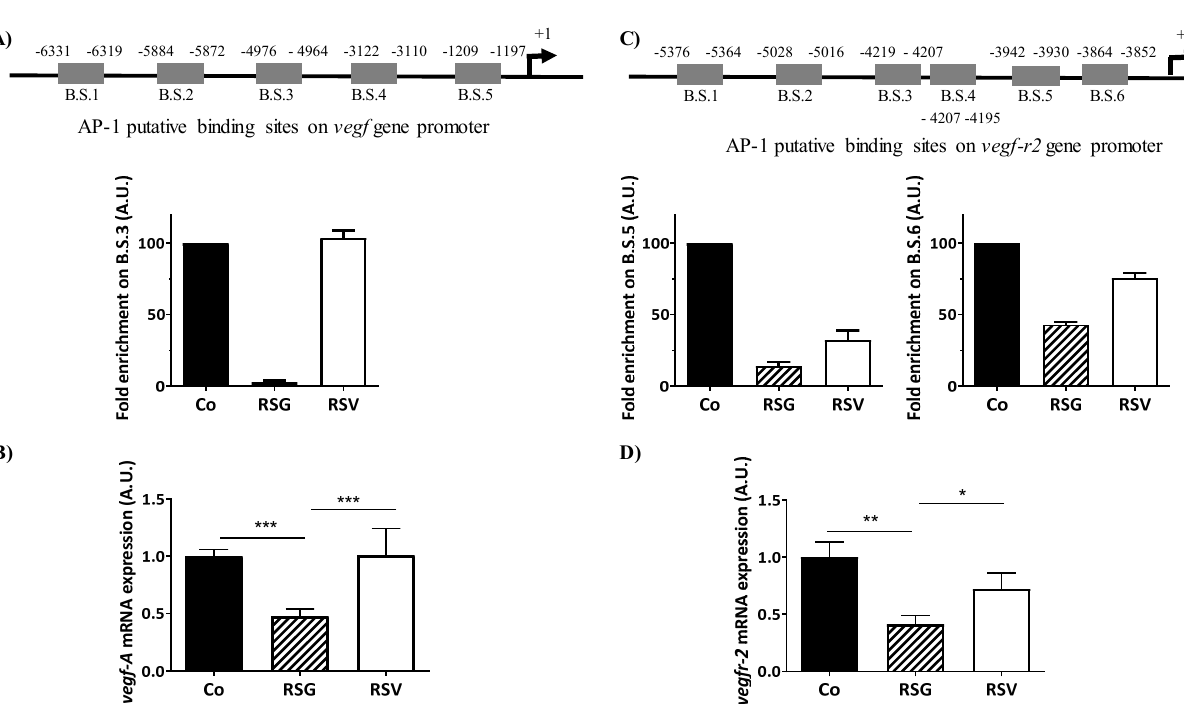
Figure 6. RSG inhibits vegf-a and vegf-r2 mRNA expressions through a disruption of the AP-1 binding sites. ARPE-19 cells were untreated (Co) or treated with RSG (12 µM) or with RSV (20 µM) for 24 h. ( A ) Upper panel, analysis on the putative binding sites of AP-1 on the vegf-a gene promoter. Down panel, ChIP analysis of the interaction between AP-1 and the vegf promoter in ARPE-19 cells. Analysis of the putative B.S.3 for AP-1 on the vegf promoter ( − 4976 − 4964) is shown. For the putative B.S.1, B.S.2, B.S.4, and B.S.5, any amplification was obtained. ( B ) RT-qPCR mRNA expression analysis of vegf-a . Data represent three independent experiments. Data are expressed as the mean fold induction ± SEM of three independent experiments. p values were determined by a one-way ANOVA followed by Tukey’s multiple comparison test. * p < 0.05, ** p < 0.01 and *** p < 0.001. ( C ) Upper panel, analysis of the putative binding sites of AP-1 on the vegf-r2 gene promoter. Down panel, ChIP analysis of the interaction between AP-1 and the vegf-r2 promoter in ARPE-19 cells. Analysis of the putative B.S.5 and B.S.6 for AP-1 on the vegf-r2 promoter ( − 3942, − 3930, and − 3864, − 3852, respectively) is shown. For the putative B.S.1, B.S.2, B.S.3, and B.S.4, any amplification was obtained. ( D ) RT-qPCR mRNA expression analysis of vegf-r2 . Data represent three independent experiments. Data are expressed as the mean fold induction ± SEM of three independent experiments. p values were determined by a one-way ANOVA followed by Tukey’s multiple comparison test. * p < 0.05, ** p < 0.01 and *** p <